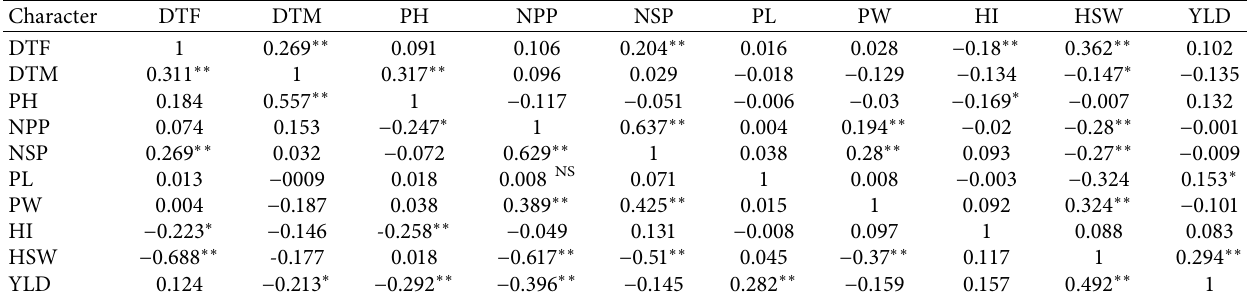
Table 5: Phenotypic (above diagonal) and genotypic (below diagonal) correlation coefcients of 100 common bean genotypes were tested at Jimma